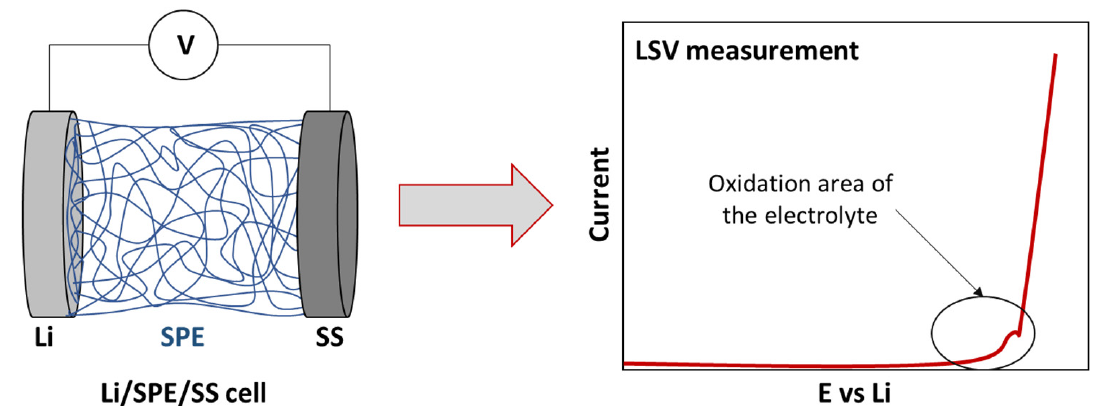
Figure 3. Scheme of traditional cell for ESW evaluation by LSV measurement.